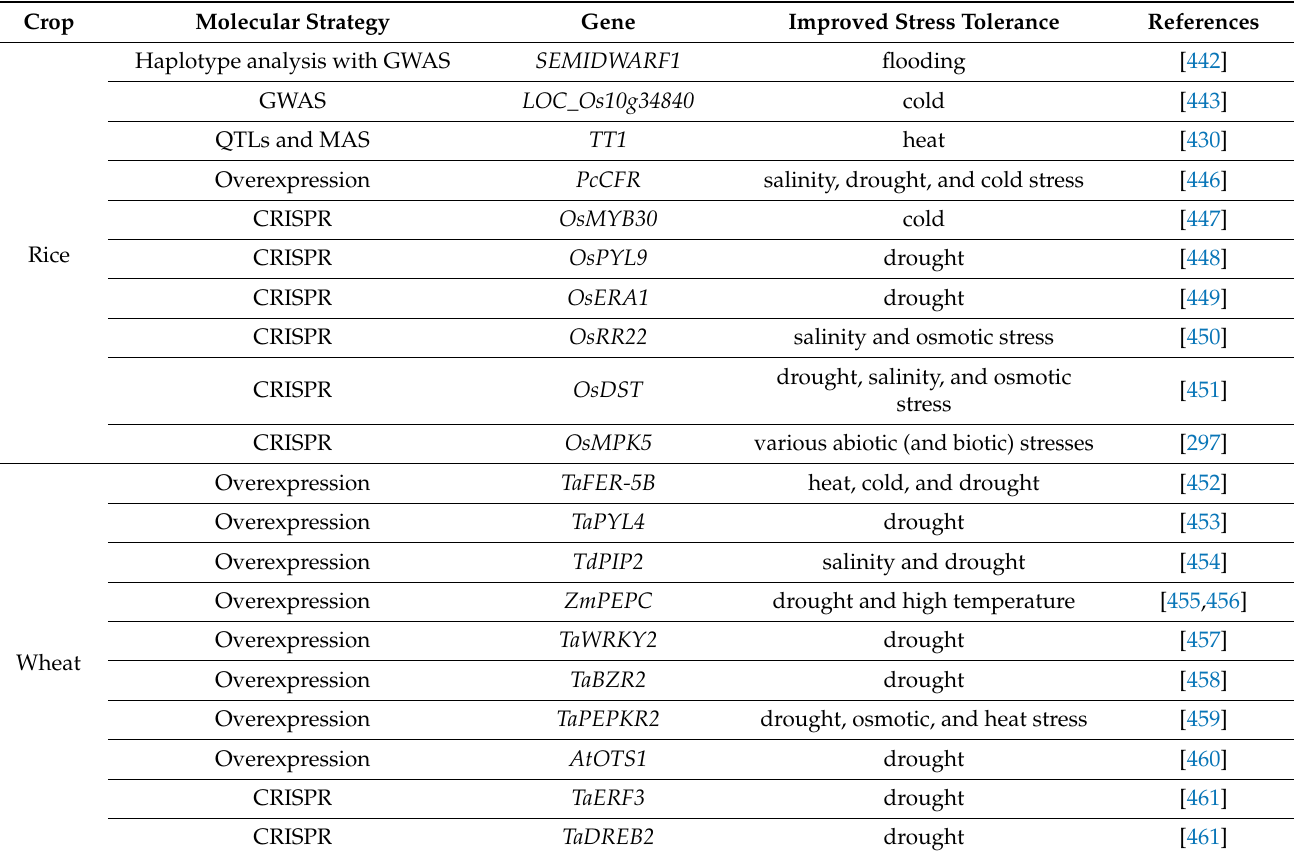
Table 2. Recent examples of genes used to improve abiotic stress tolerance in the three main cereal crops, rice, wheat, and